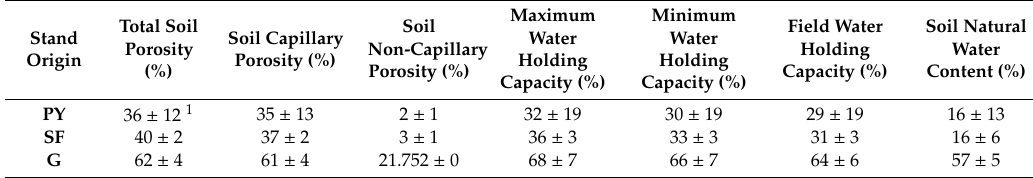
Table 2. Basic soil characteristics of the experimental sites.